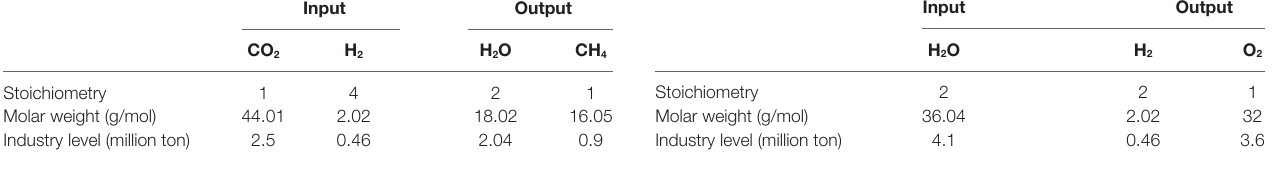
TaBle 4 | Overview of mass flows in methanation reaction on a molar and industry level.